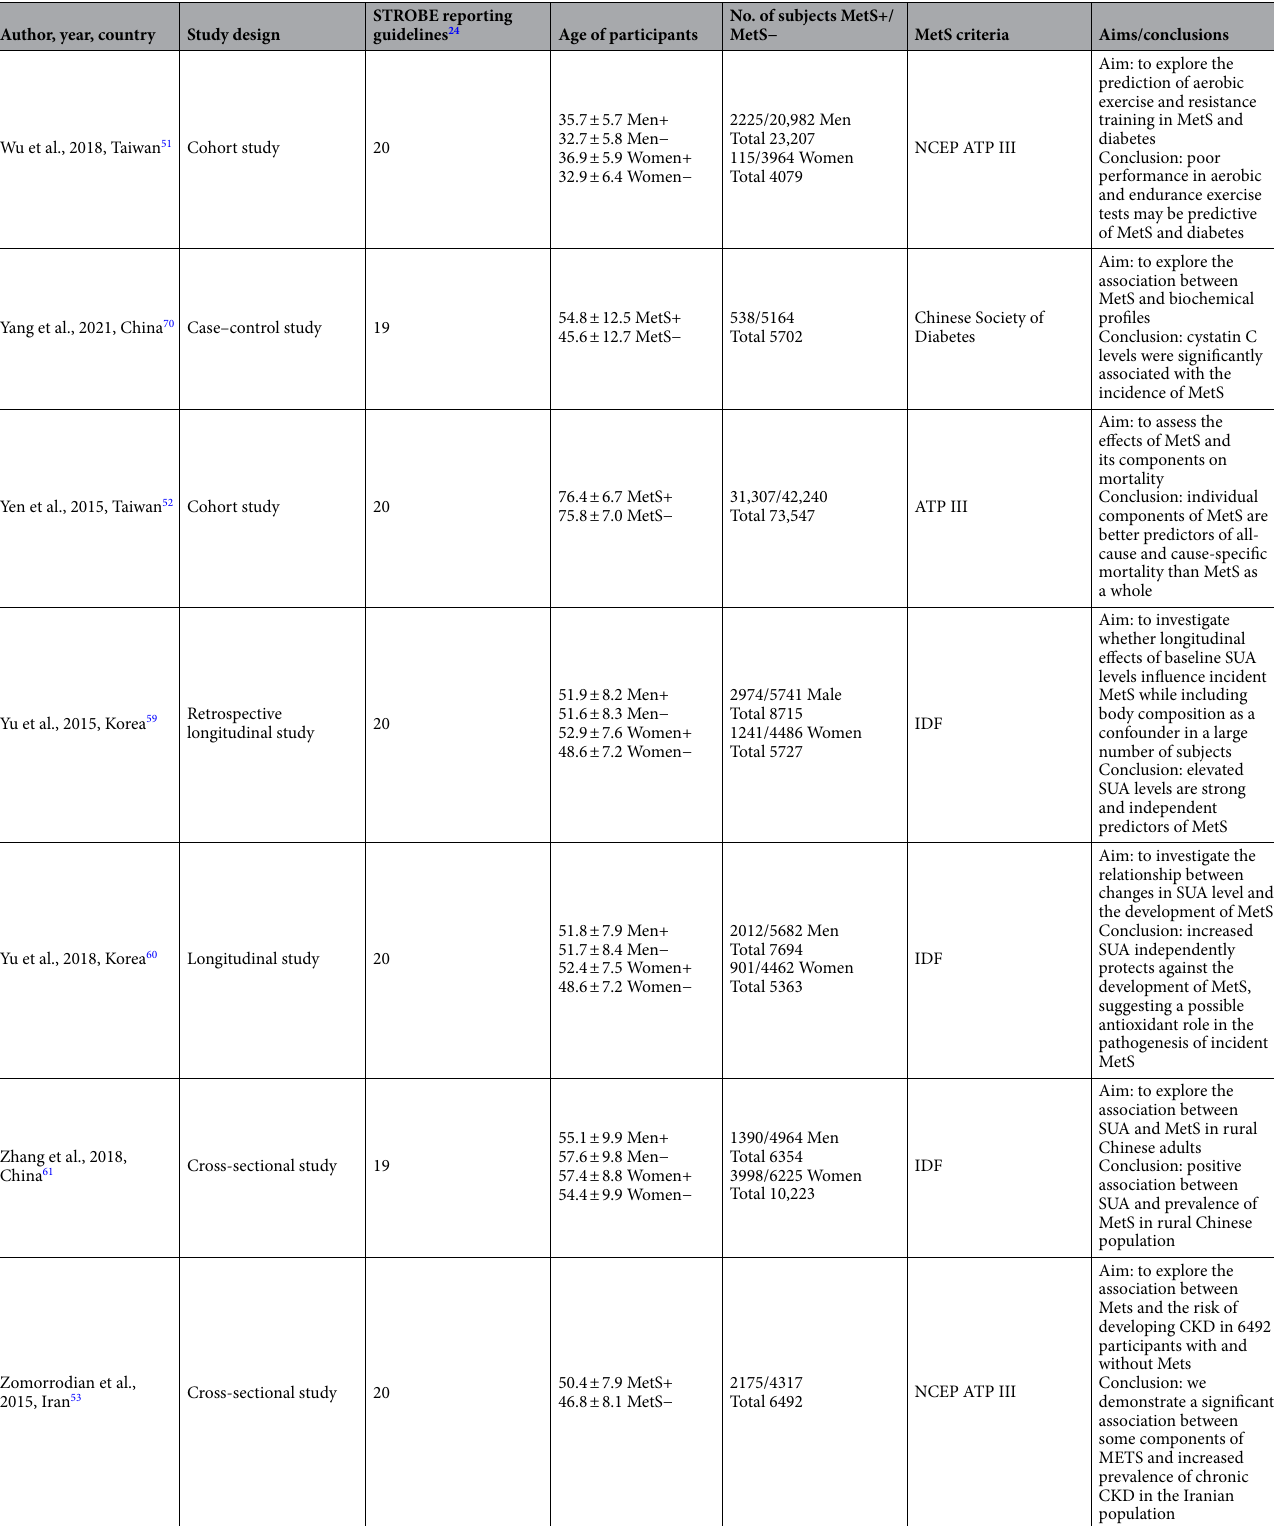
Table 1. Characteristics of included studies (n = 43). STROBE Strengthening the Reporting of Observational Studies in Epidemiology, MetS metabolic syndrome, Dx diagnosis, IDF International Diabetes